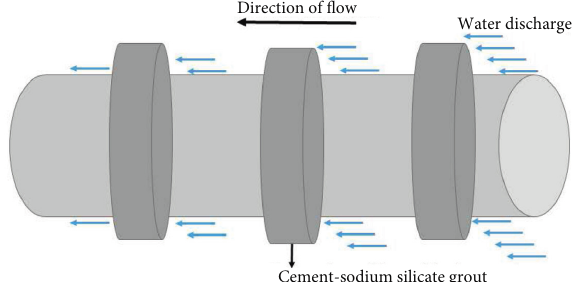
Figure 11: Schematic diagram of